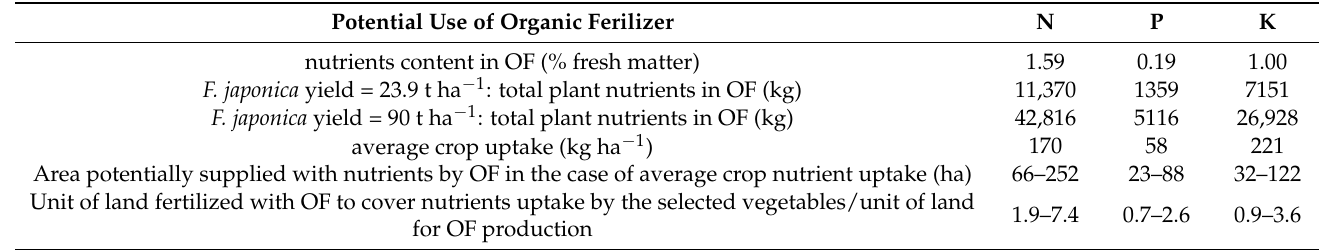
Table 8. Area (ha) potentially supplied with nutrients by F. japonica organic fertilizer produced on 34 ha when considering average crop uptake according to technological instructions for integrated vegetable production